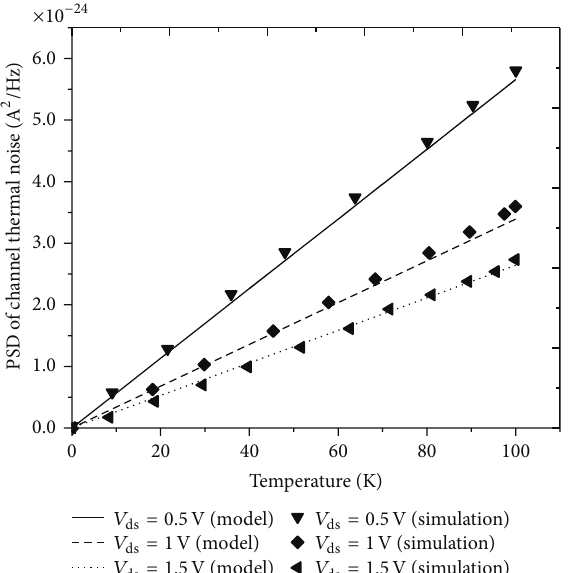
Figure 7: Characteristic of PSD of channel thermal noise versus